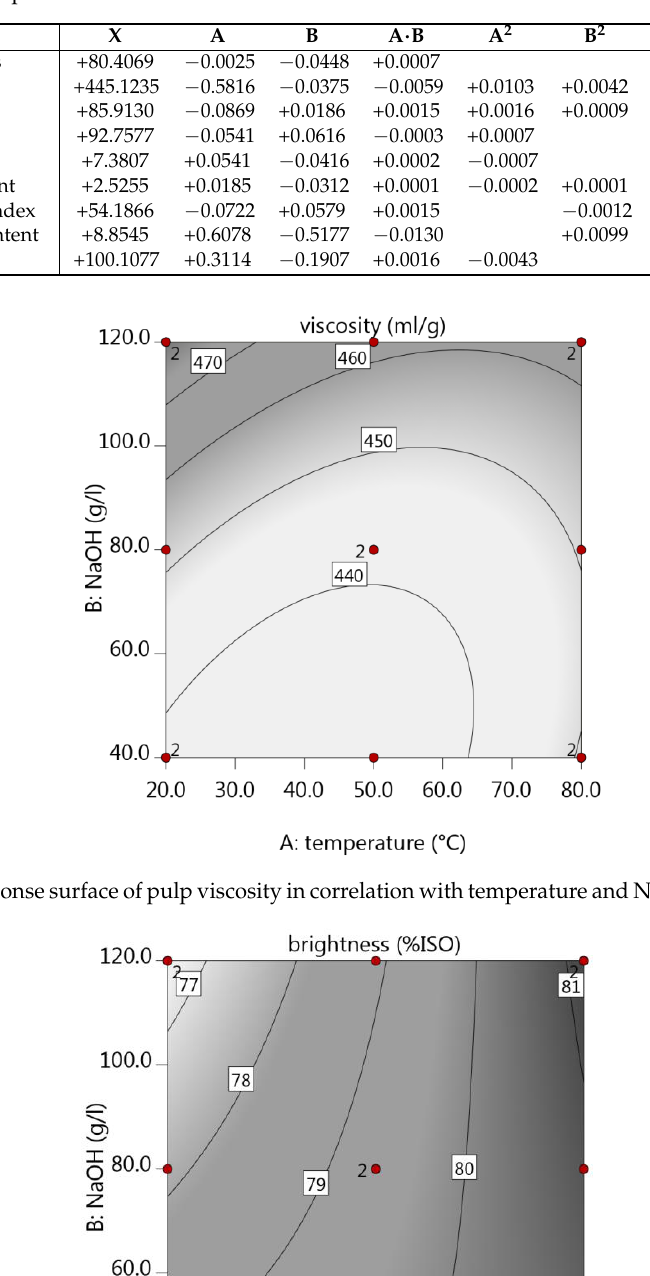
Table A2. Coefficients of response regression models with the equation: response = X + A + B + A · B + A 2 + B 2 . A is temperature and B is NaOH concentration.